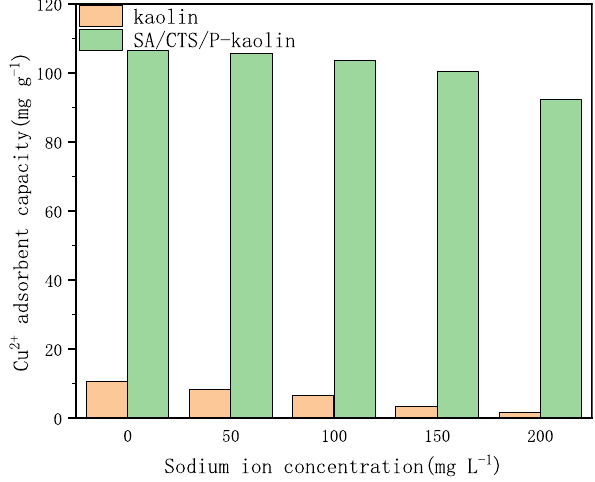
Figure 8: E ff ect of Na + concentration on Cu 2 + adsorption.